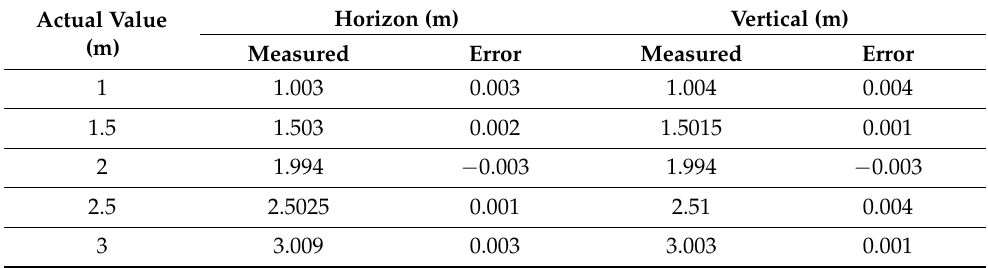
Table 2. Tag recognition performance at 50 m.